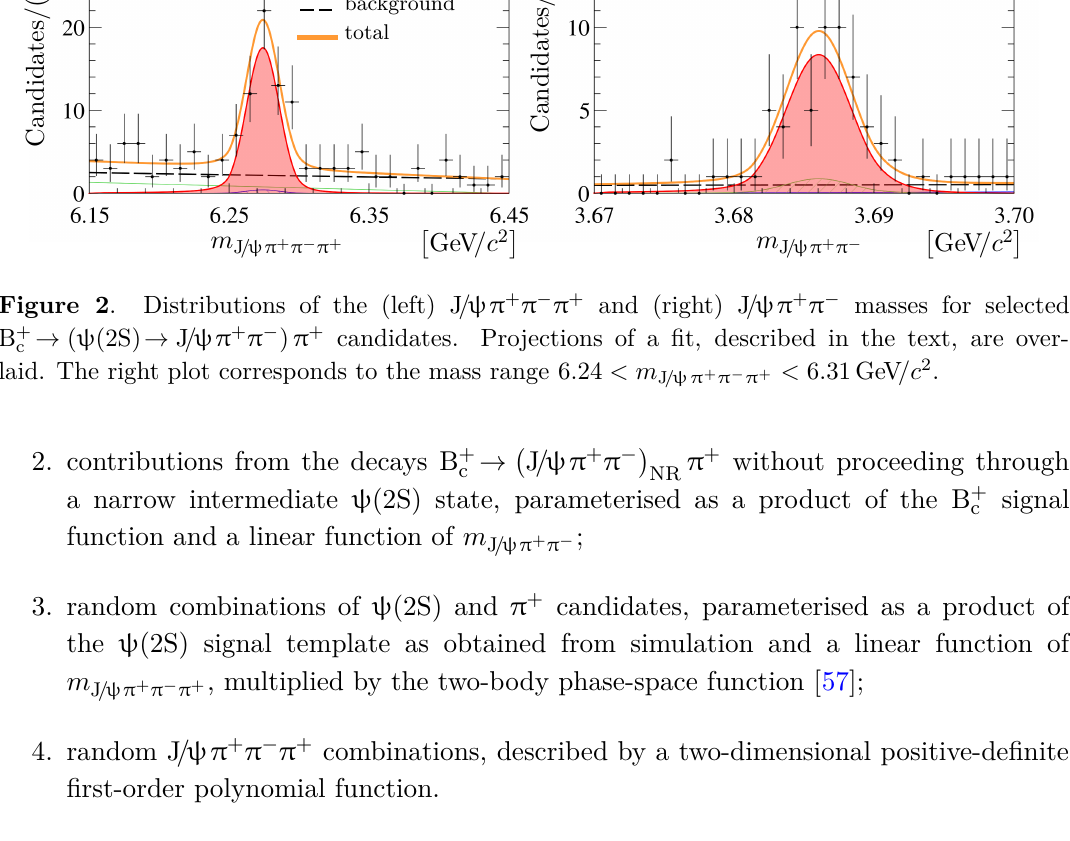
< 6 . 31 GeV/ c 2 J / (cid:25) + (cid:25) − (cid:25) +